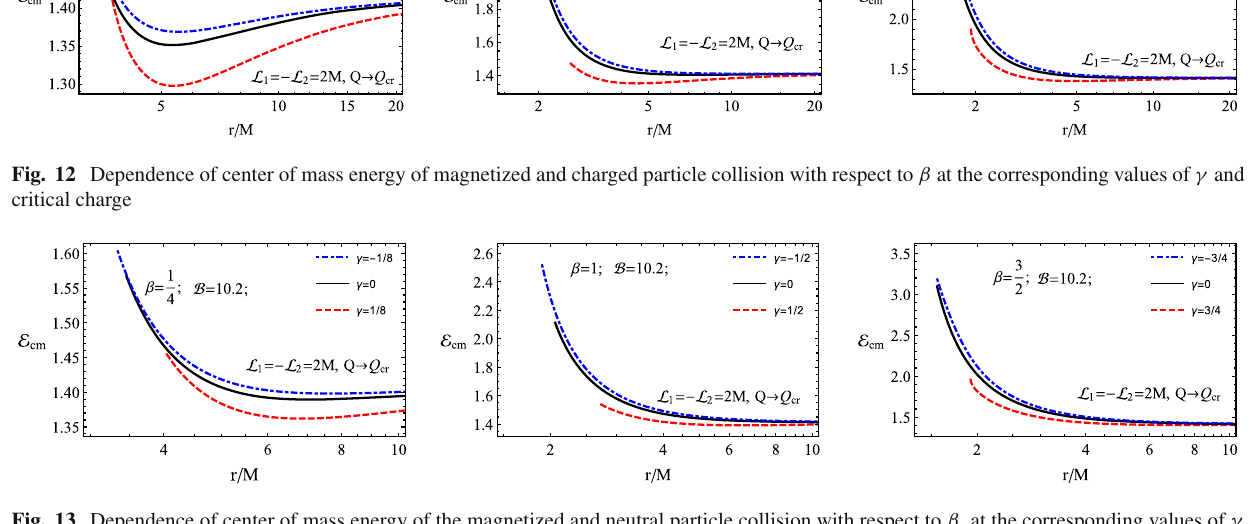
Fig. 13 Dependence of center of mass energy of the magnetized and neutral particle collision with respect to β , at the corresponding values of γ and critical